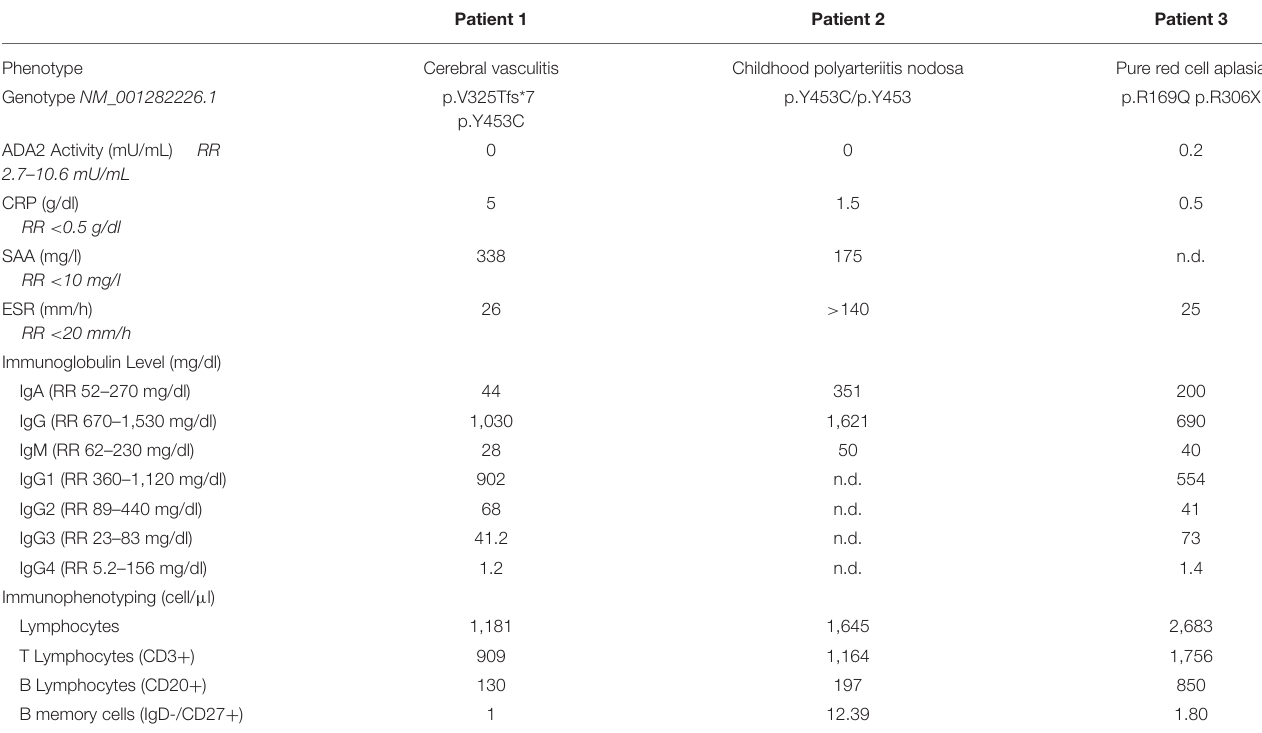
TABLE 1 | Characteristics of three patients with adenosine deaminase 2